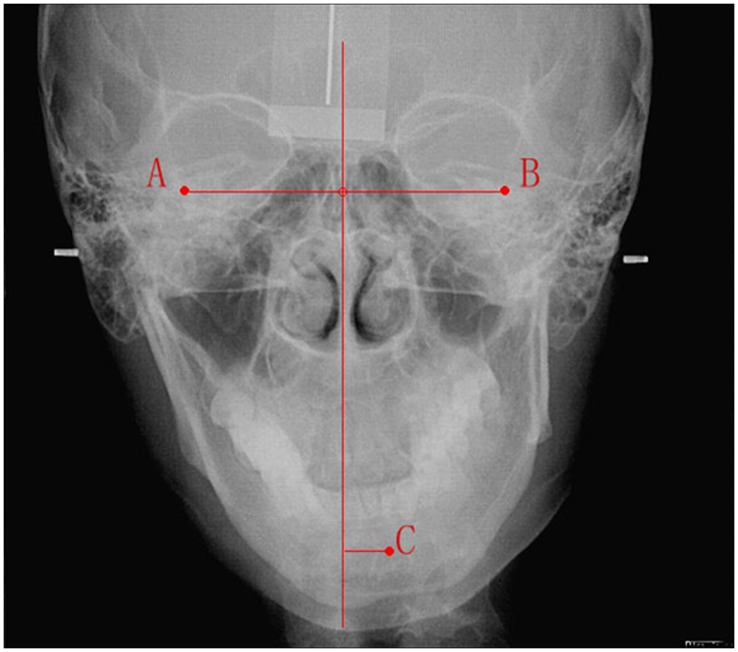
Anterior X-ray film of head.The midpoints of the inferior orbital fissures were designated as points A and B, and the midpoint of the chin ridge was as point C.